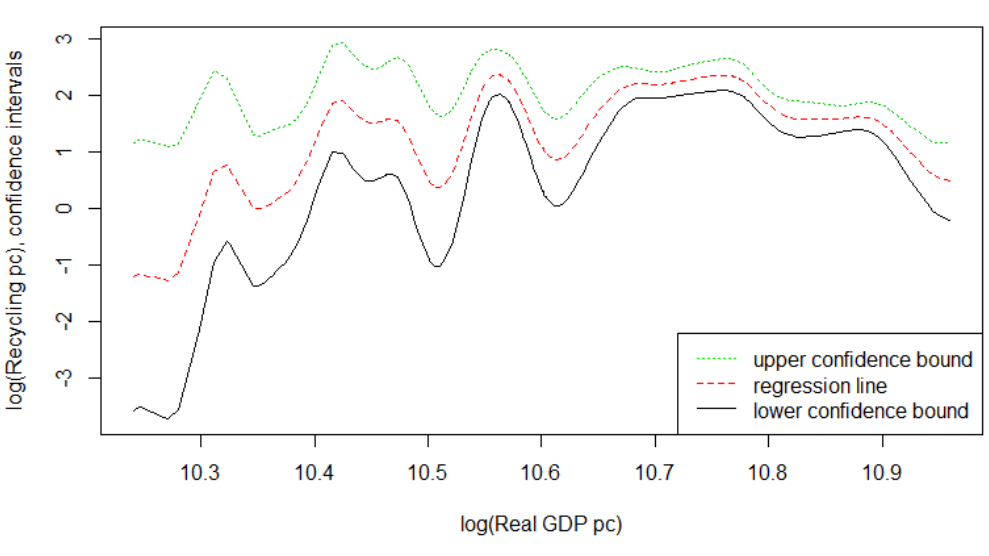
Figure 3. Relationship between log of Recycling and log of Real GDP per capita for middle rich States.